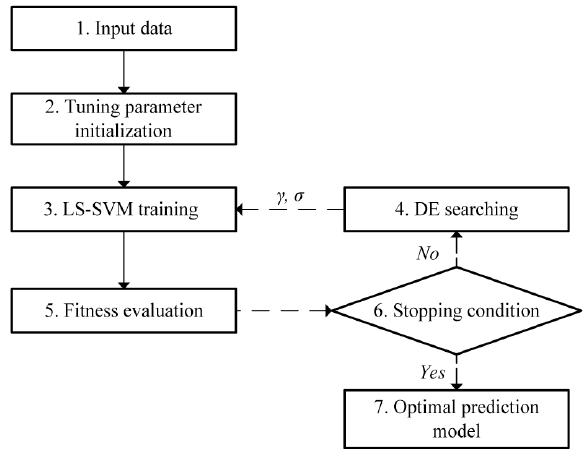
Fig. 3. Evolutionary Least Squares Support Vector Machine Inference Model for Groutability Prediction (ELSIM-GP)